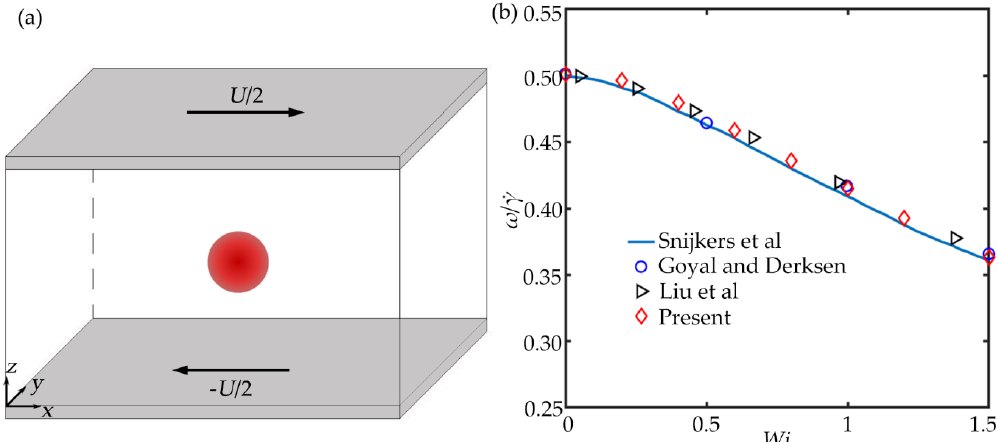
Figure 2. Numerical and analytical results of the velocity distribution ( a ), the normal-stress components τ xx ( b ), and the extra-stress components τ xy ( c ) at the channel center plane under Wi = 0.3, Re = 1.0, and β = 0.3.